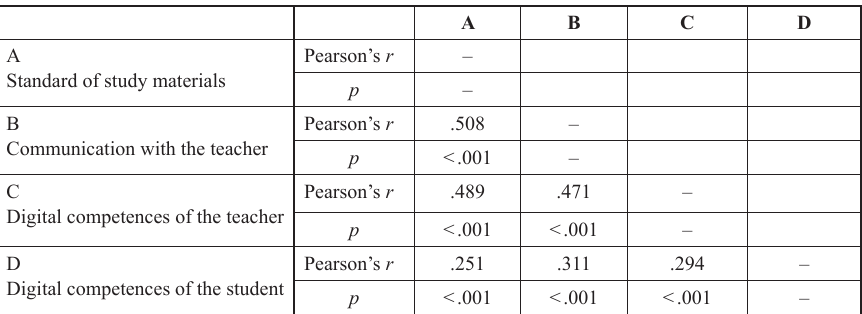
Table 13. Correlation